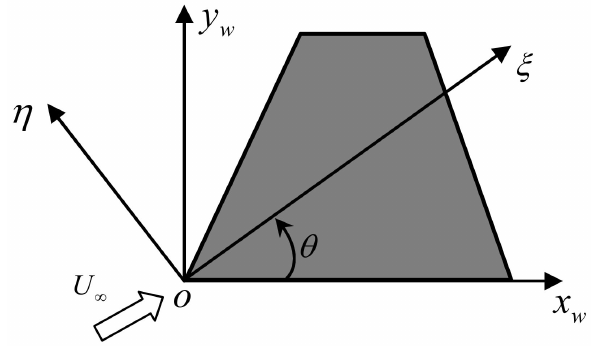
Figure 5. Definition of the deflection angle θ of the air